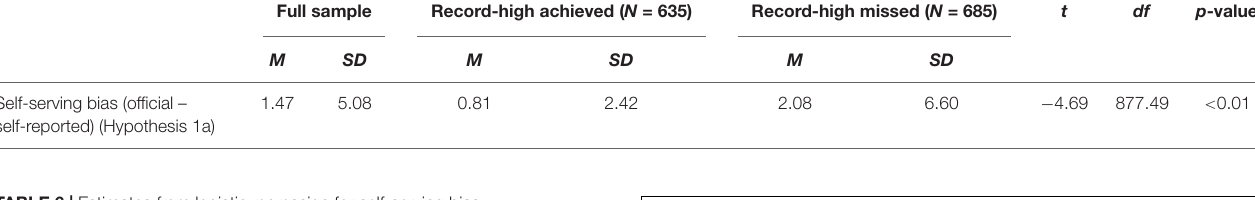
TABLE 6 | Estimates from logistic regression for self-serving bias.